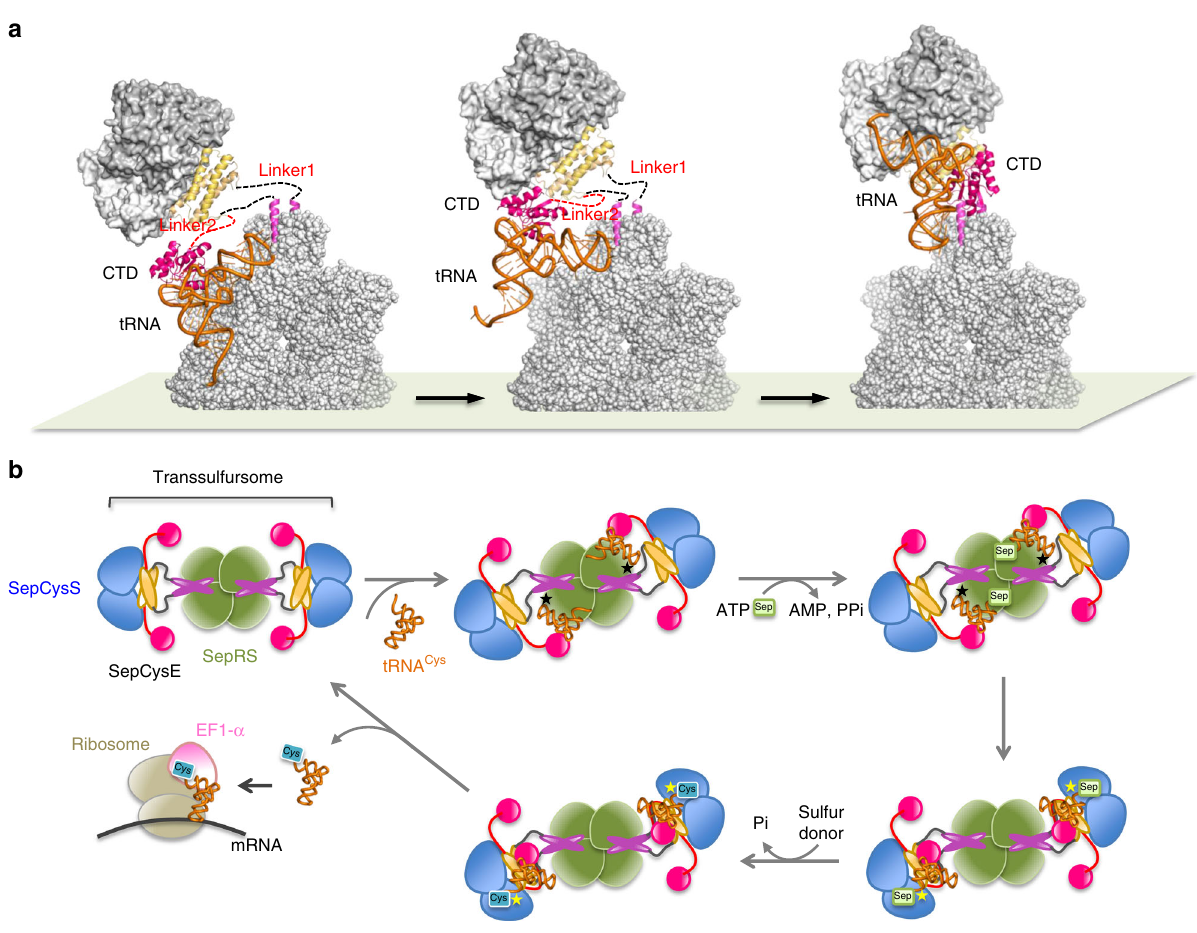
Fig. 5 Proposed mechanism of the tRNA-dependent cysteine biosynthesis by transsulfursome. a tRNA channeling for consecutive reactions of the transsulfursome. Only upper half of the transsulfursome is drawn here. (Left) The fi rst reaction state (SepRS active form). This model was built by superposing the SepCysE(CTD)-tRNA Cys complex (present work) with the SepRS-tRNA complex (PDB:2DU3). The stretching of linker1 and linker2 allows the SepCysE(CTD)-tRNA Cys complex to reach the binding site on SepRS, while anchoring SepCysE(N-helix) to its binding site on SepRS. The anticodon of tRNA Cys is recognized by the site close to the SepCysE(N-helix) binding site. (Middle) The intermediate state. The mischarged Sep-tRNA Cys moves from the fi rst reaction site on SepRS to the second reaction site on SepCysS without being released from bound SepCysE(CTD). Two fl exible linkers of SepCysE allow the movement of Sep-tRNA Cys over this long distance. (Right) The second reaction state (SepCysS active form). The discriminator base of U73 and possibly the Sep moiety of Sep-tRNA Cys are recognized by SepCysS, followed by conversion to the canonical Cys-tRNA Cys . The anticodon of tRNA Cys may not be recognized by SepRS in this step. b A schematic drawing of the tRNA-dependent cysteine biosynthesis by transsulfursome. N-helix (purple) and NTD (orange) of SepCysE bridge the SepRS (green) and SepCysS (blue) to form ternary complex (transsulfursome) with a molar ratio of 4:4:4. SepCysE (CTD) (red) shuttles tRNA Cys between two distinct active sites on transsulfursome for sequential reactions catalyzed by SepRS and SepCysS. Each of the two enzymes recognizes tRNA Cys separately in the two steps. The released Cys-tRNA Cys is delivered to ribosome by EF-1 α to fi nally incorporate a cysteine into proteins. Two tRNA substrates are bound to the opposite positions on transsulfursome. The recognition sites of tRNA Cys by SepRS and SepCysS are marked with black and yellow asterisks,